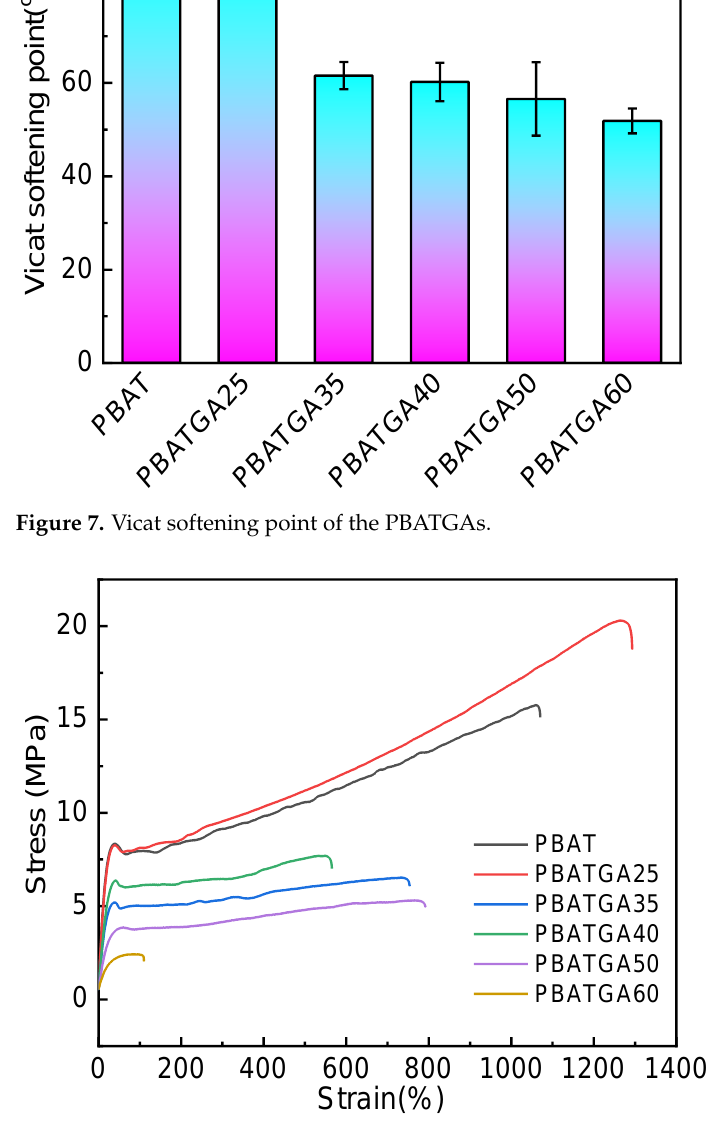
Figure 8. Stress – strain curves of PBATGAs.